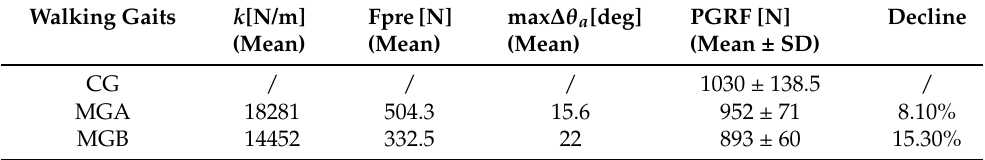
Table 6. Walking PGRF at about 0.25 m/s.